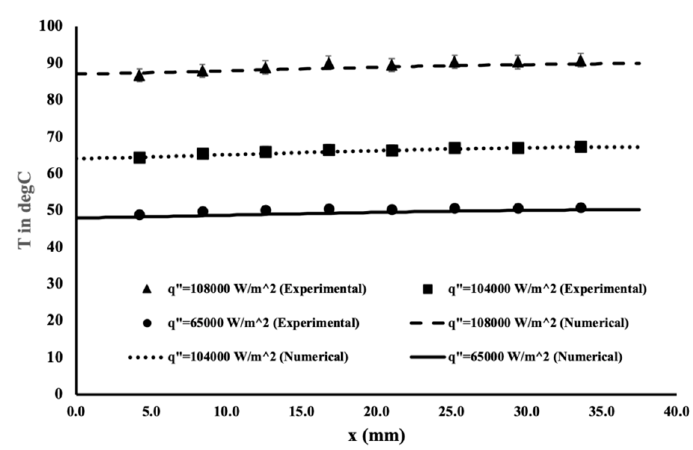
Figure 2. Experimental measurement and numerical computation (0.1% Al 2 O 3 –water nanofluid).